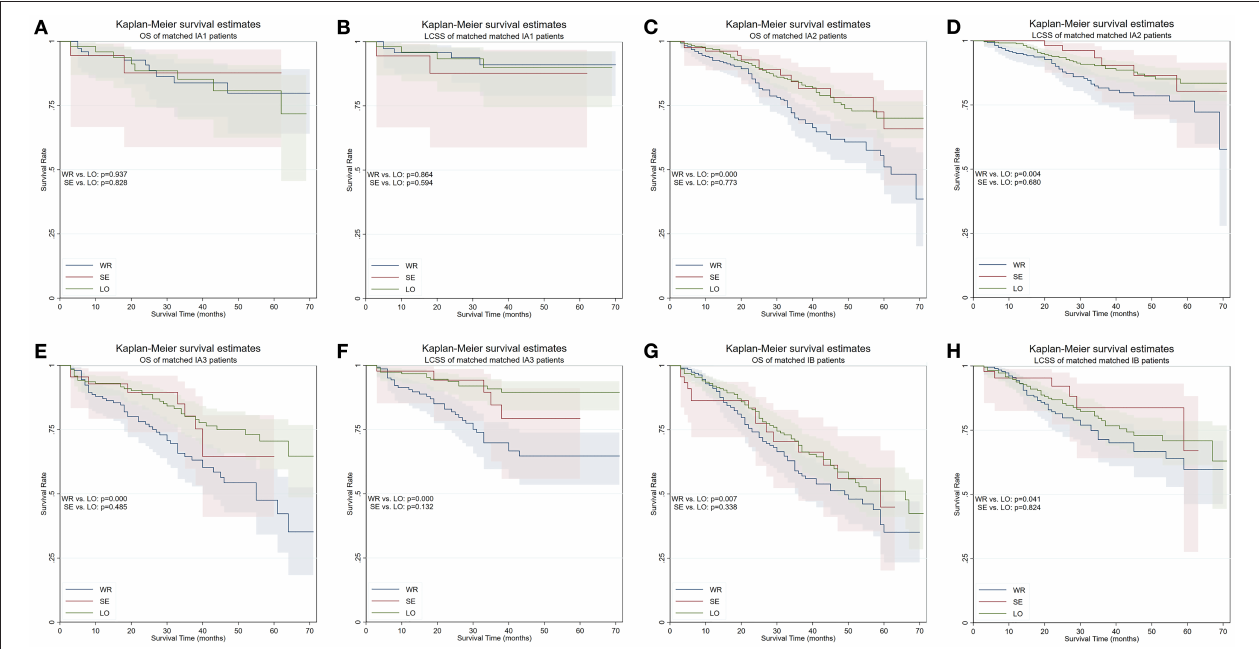
FIGURE 4 | OS and LCSS of PS-matched patients with NSCLC in four TNM stages. (A) OS of patients with stage IA1 NSCLC. (B) LCSS of patients with stage IA1 NSCLC. (C) OS of patients with stage IA2 NSCLC. (D) LCSS of patients with stage IA2 NSCLC. (E) OS of patients with stage IA3 NSCLC. (F) LCSS of patients with